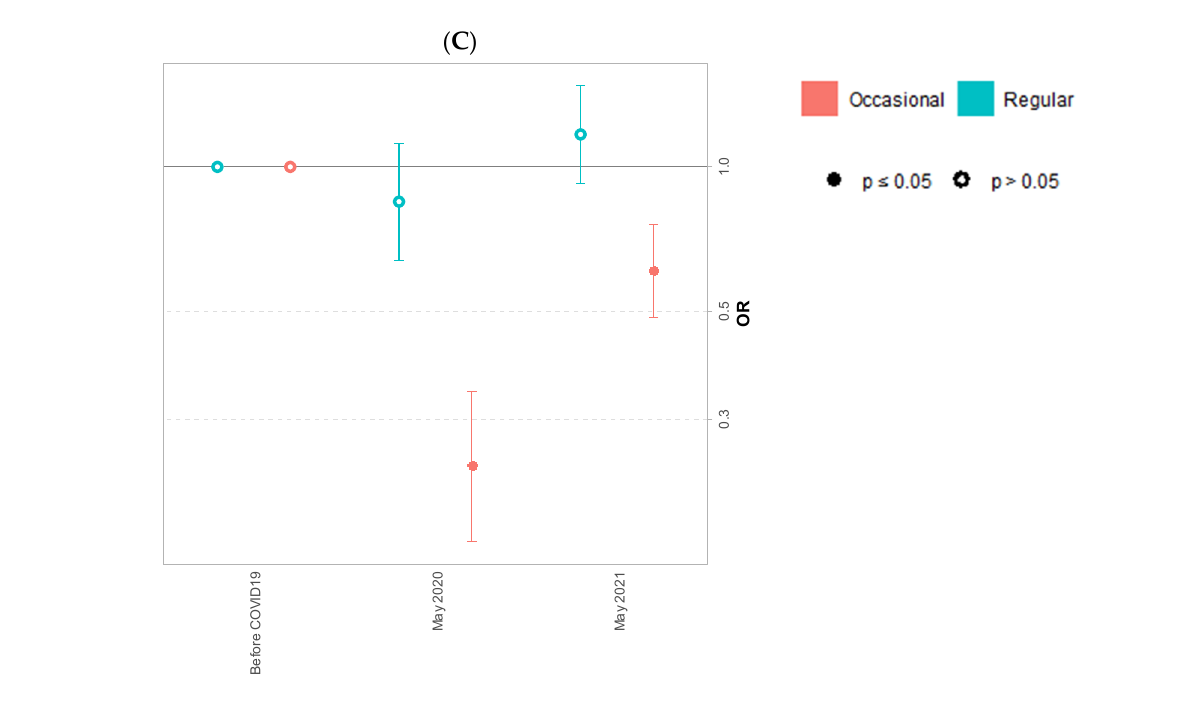
Figure 3. Adjusted odds ratio and Confidence Interval 95% for occasional and regular tobacco smoking ( A ), binge drinking ( B ) and cannabis use ( C ) of university students in May 2020 and May 2021 compared to the pre-COVID-19 period.